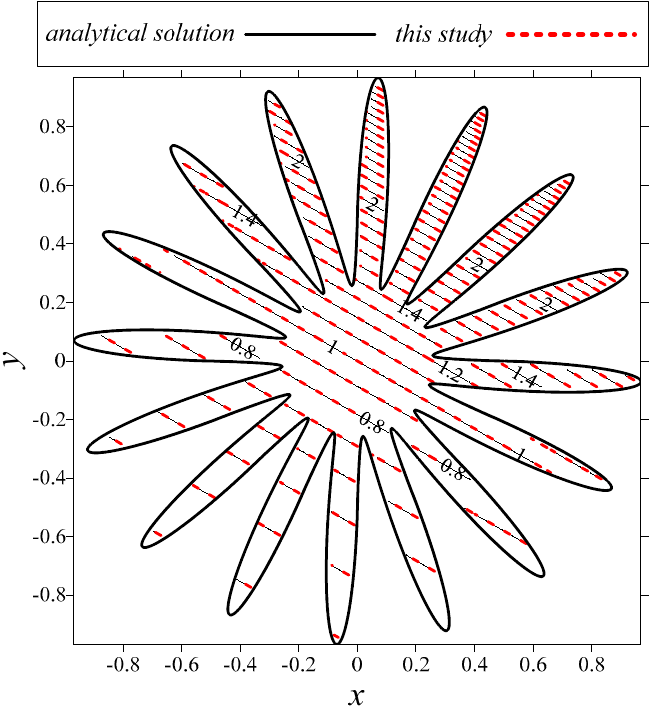
Figure 6. Results comparison between this study and the analytical solution.